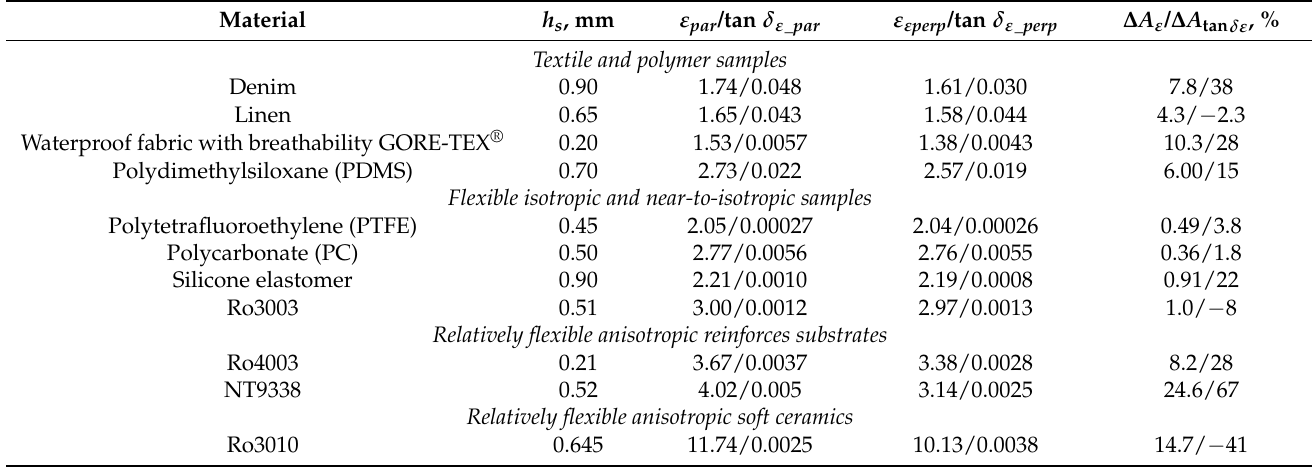
Table 1. Measured dielectric parameters and anisotropy of selected materials for this research (averaged values for the frequency interval 6–13